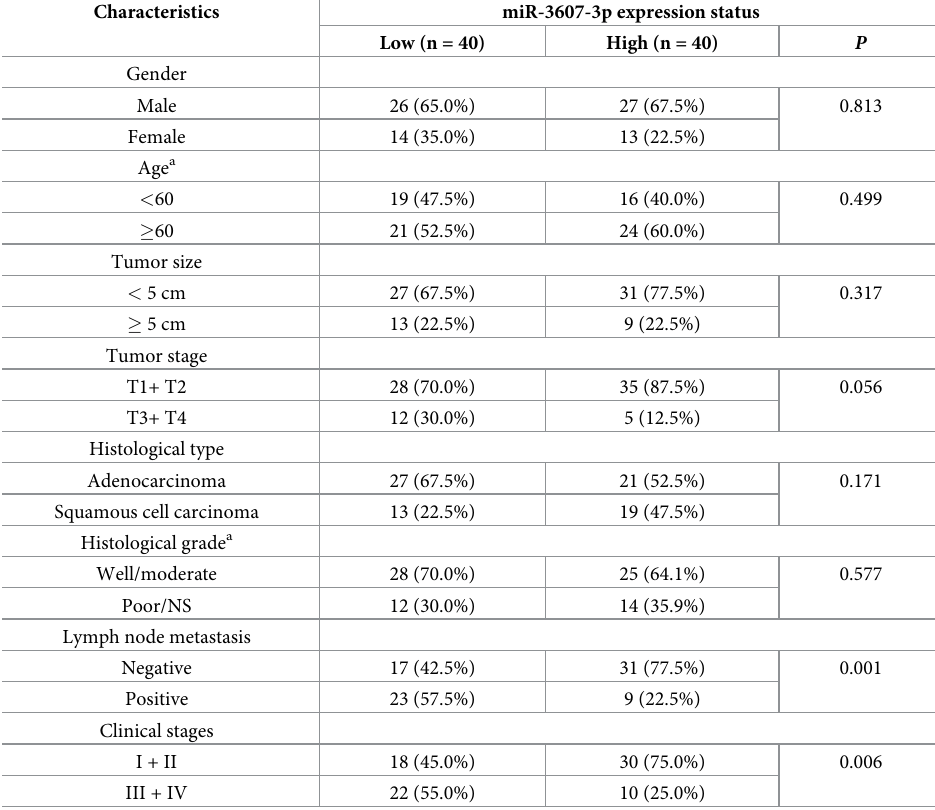
Table 3. Serum expression levels of miR-3607-3p and clinicopathological characteristics in patients with